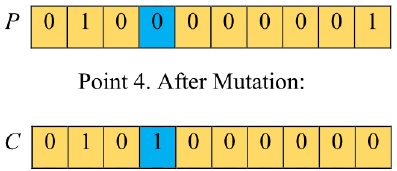
Figure 4. Example of the effective bit flip